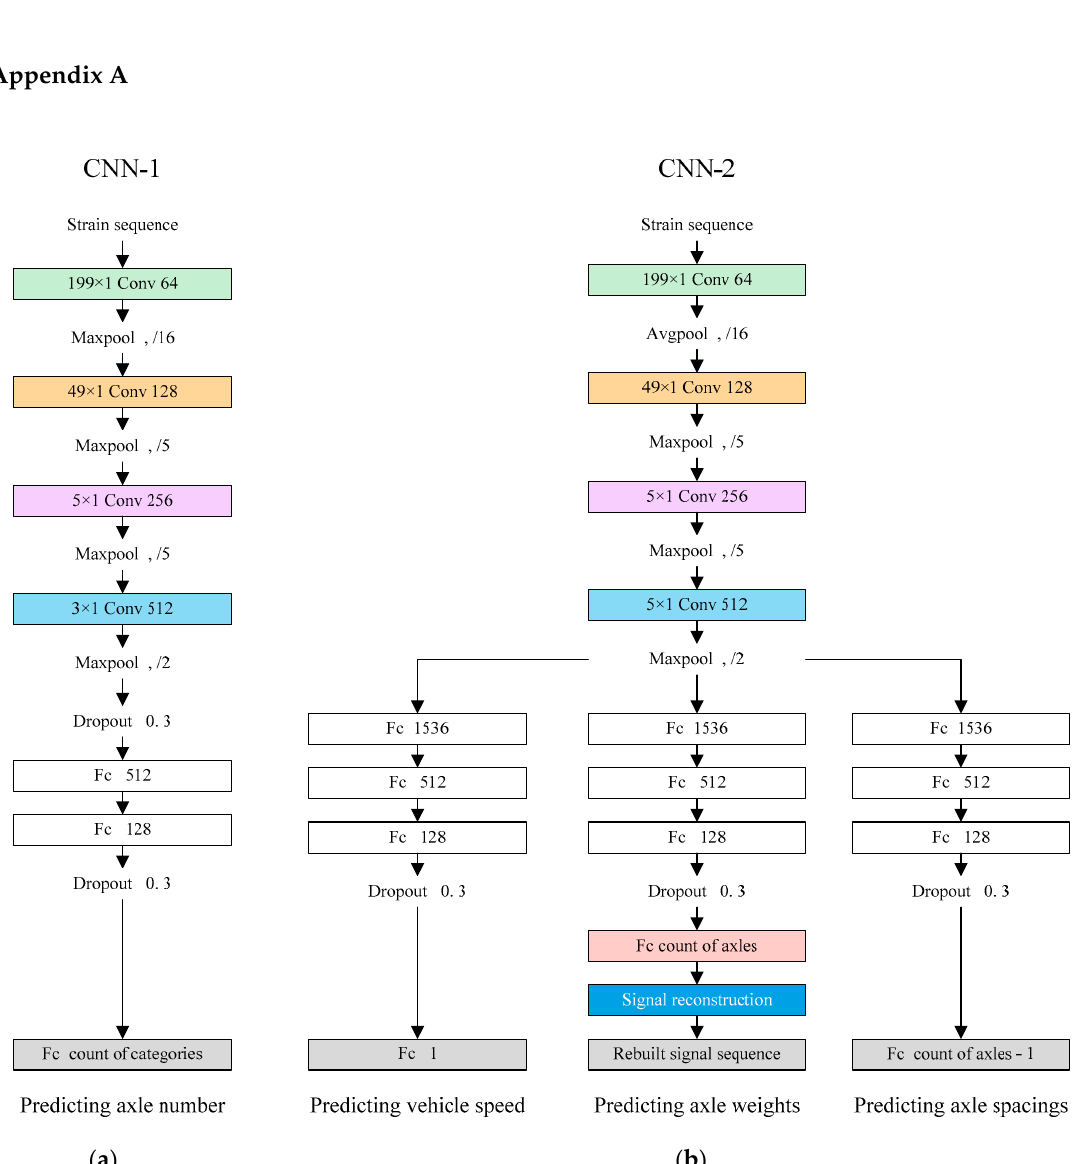
Figure A1. Structure of convolutional neural networks: ( a ) structure of the axle count predicting neural network; ( b ) structure of the neural network predicting speed, axle weights and axle spacings of vehicles. Conv, Convolutional layer; Fc, Fully connected layer; Coe ffi cient of L2 regularization = 10 − 5 , Learning rate = 10 − 4 , Dropout coe ffi cient =